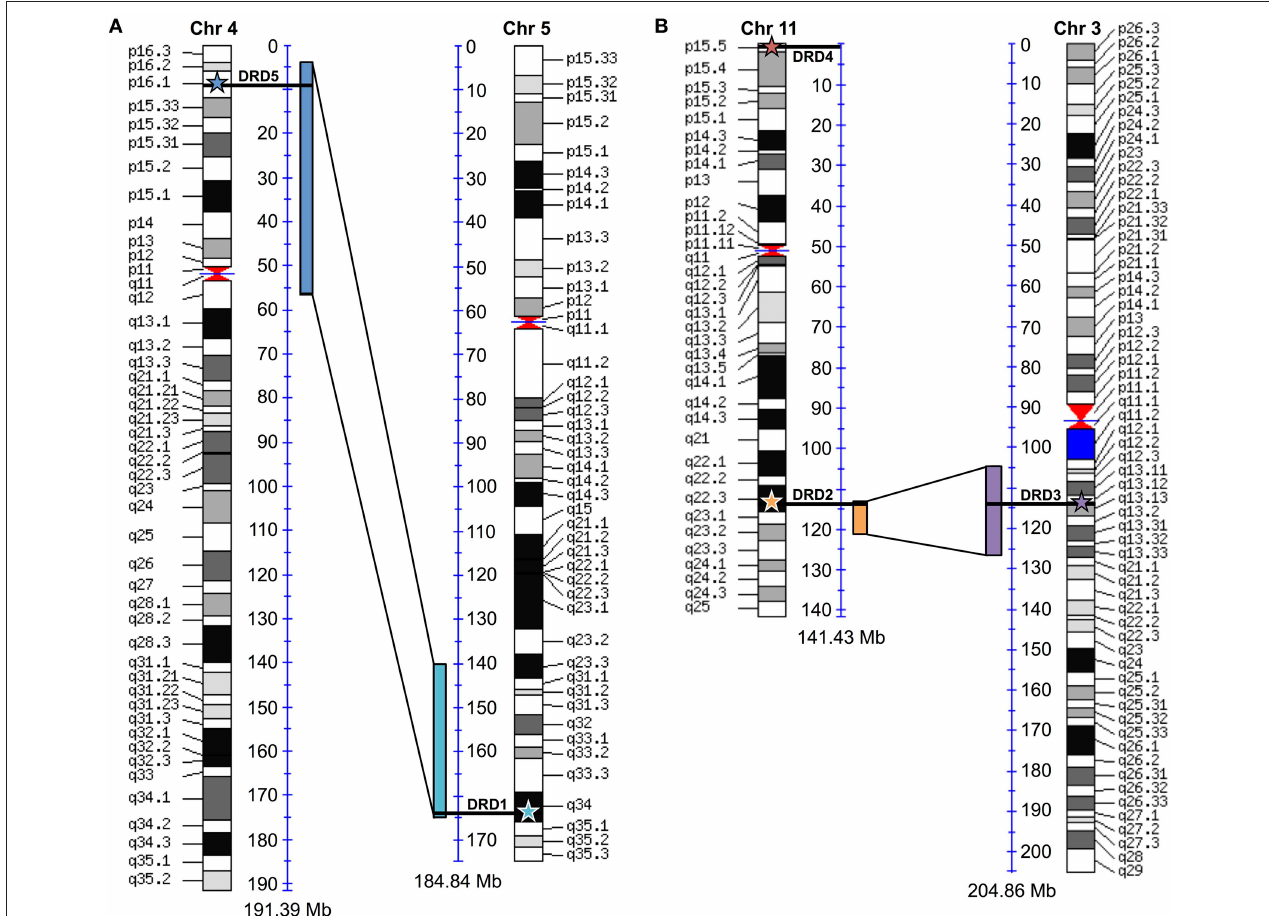
FIGURE 6 | Human paralagon maps. Human chromosome maps showing regions previously classified as likely having originated from a whole genome duplication event in vertebrate history. (A) Human DRD1 (light blue star) and DRD5 (dark blue star) are marked on their respective chromosomes, and can be seen to fall within these regions. (B) Human DRD2 (orange star), DRD3 (purple star), and DRD4 (red star) mapped on their respective chromosomes. DRD2/DRD3 fall within these regions. Maps were generated using “Paralogons in the Human Genome” tool from the Wolfe lab, and are based on a minimum threshold for paired proteins per block greater than 12 (A) or 7 (B) . Paired proteins per block greater than 6 are statistically probable as having occurred from a WGD event rather than by chance ( McLysaght et al., 2002). Chromosome maps can be regenerated and viewed at